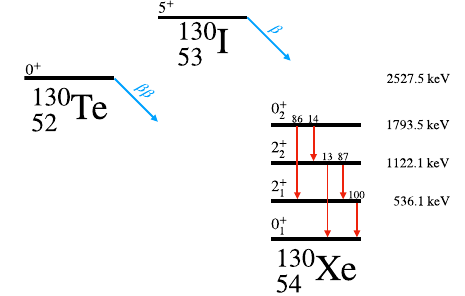
Fig. 1 The decay scheme of 130 Te is shown with details about the involved excited states of 130 Xe up to its first 0 + excited state. ,..., 0 + The nomenclature 0 + n indicates states with the same angular 1 momentum in increasing order of excitation energy. An energy scale is shown (right) where the 130 Xe ground state is taken as reference